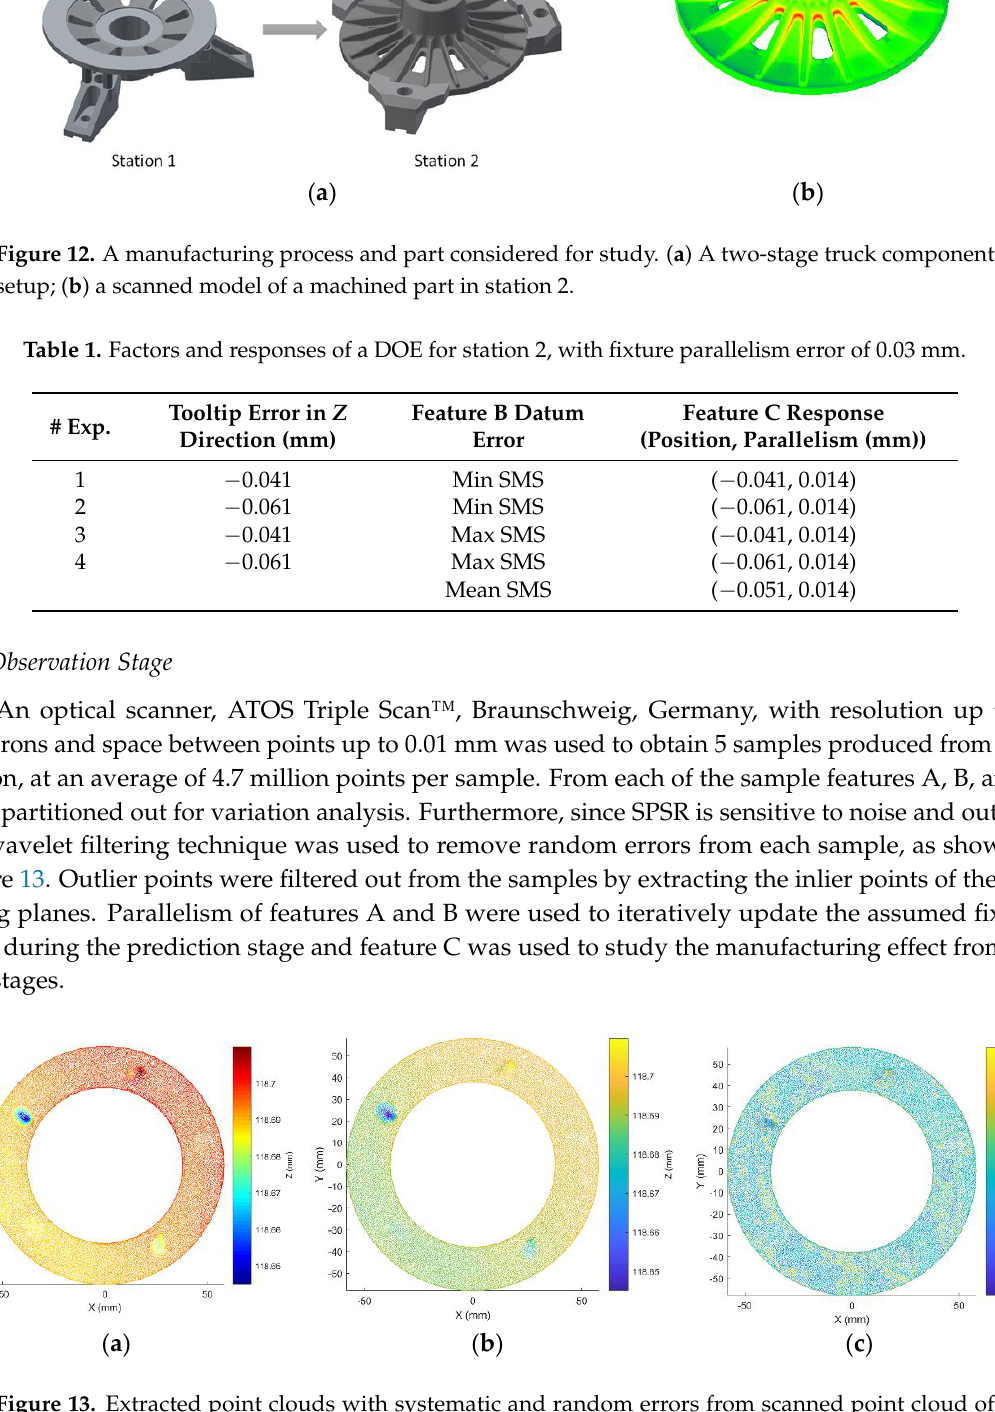
Figure 13. Extracted point clouds with systematic and random errors from scanned point cloud of feature C via wavelet filtering technique (outliers not removed). ( a ) Scanned point cloud data; ( b ) point cloud with Systematic error; ( c ) point cloud with random errors.